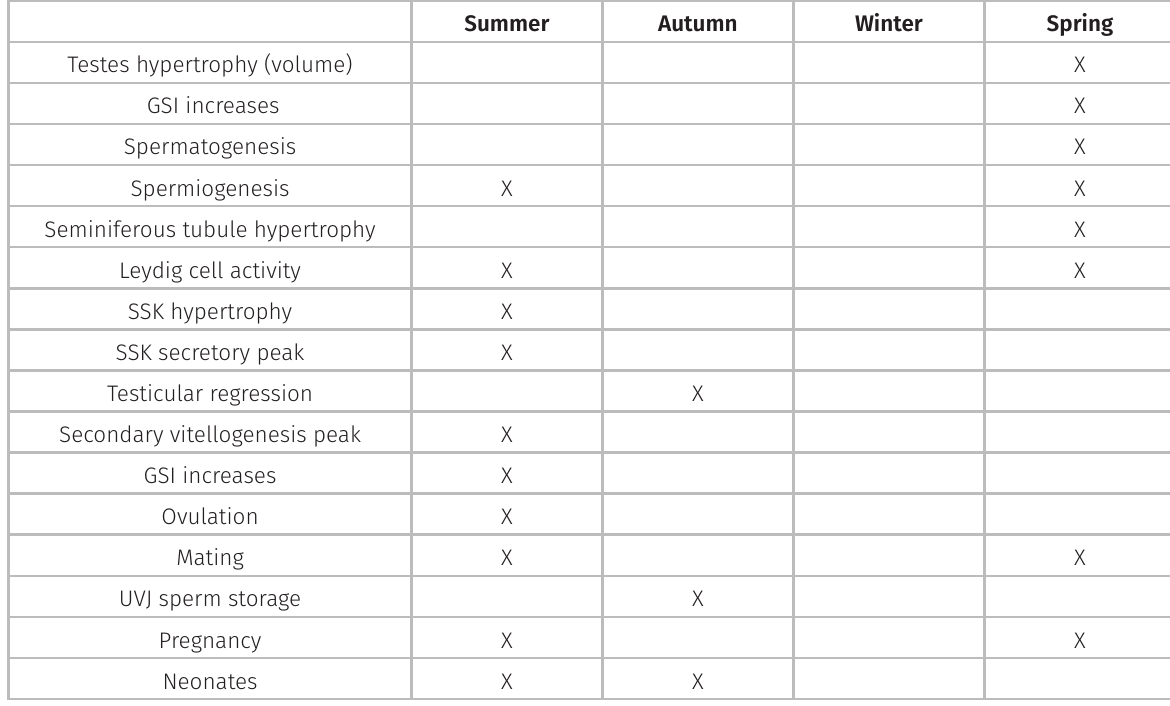
Table I. Stages of the annual reproductive cycle of males Thamnodynastes strigatus in South Brazil. Summer Autumn Winter Spring